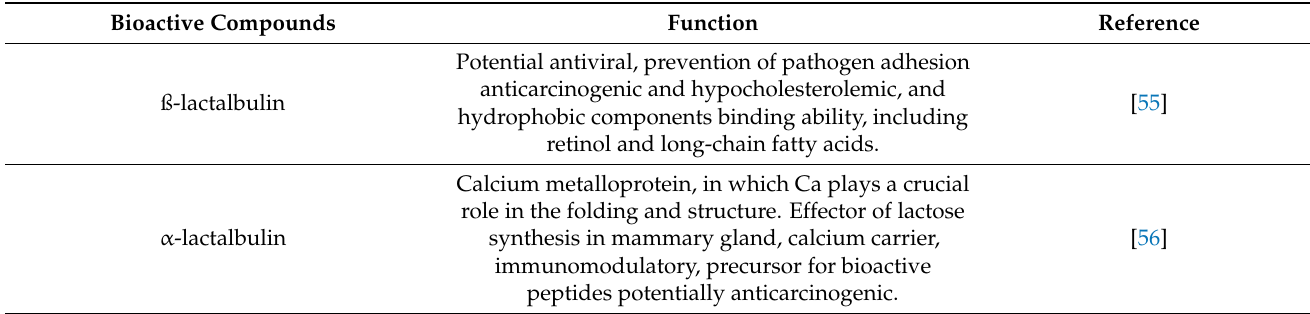
Table 3. Bioactive compounds and growth factors of